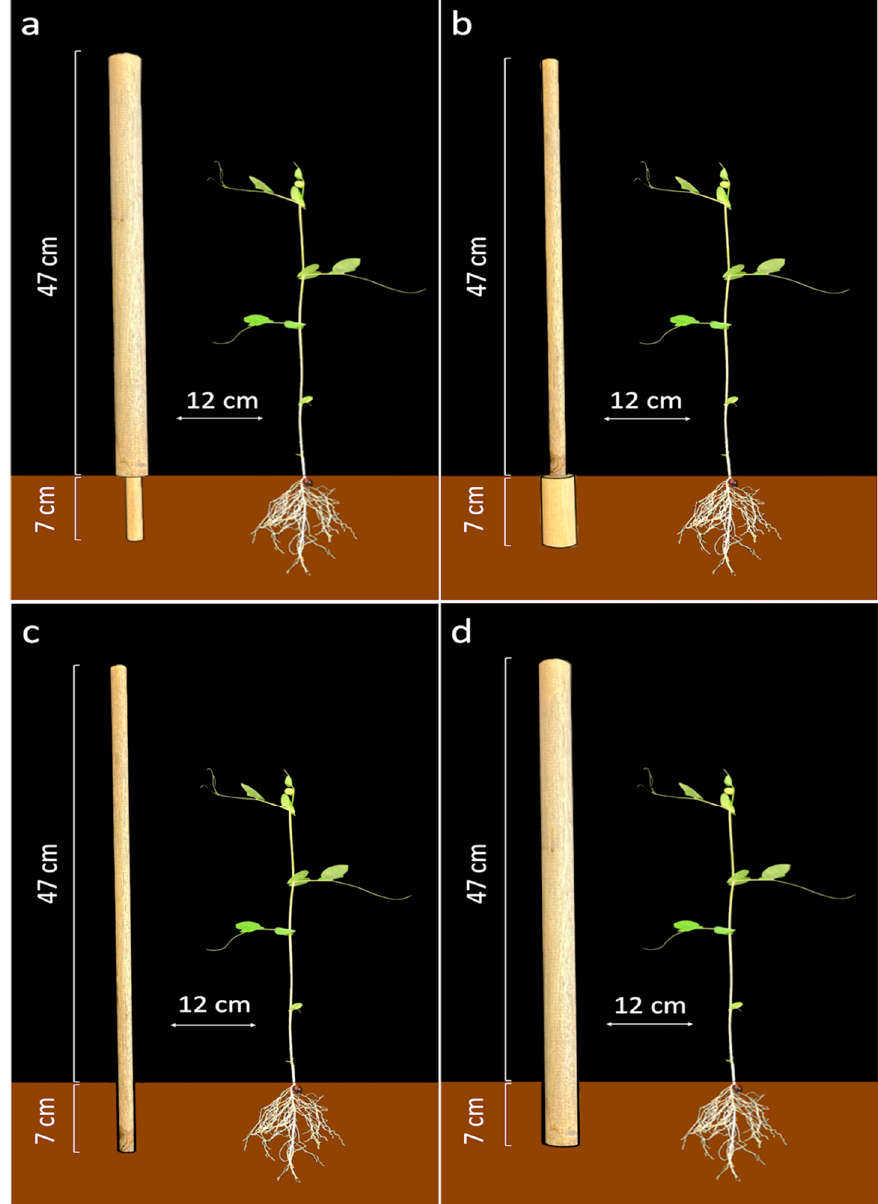
Figure 1. Supports for the: ( a ) ‘Thin-Below’ condition, ( b ) the ‘Thick-Below’ condition, ( c ) the ‘Control-Thin’ condition, and ( d ) the ‘Control-Thick’ condition. In each case the support was positioned in front of the first plant’s leaf at a distance of 12 cm.